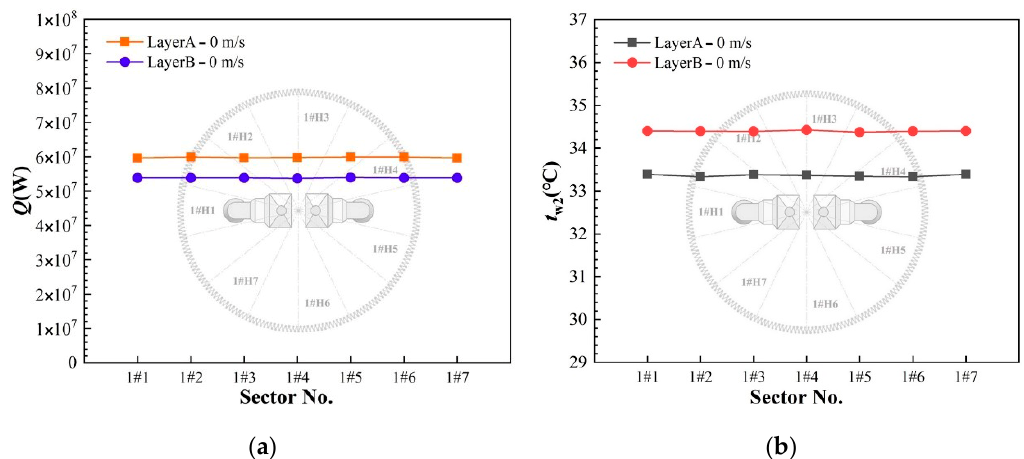
Figure 10. Heat rejections and water outlet temperatures of double-layer sectors in the absence of wind in the case of 1 unit. ( a ) Heat rejections; ( b ) water outlet temperatures.